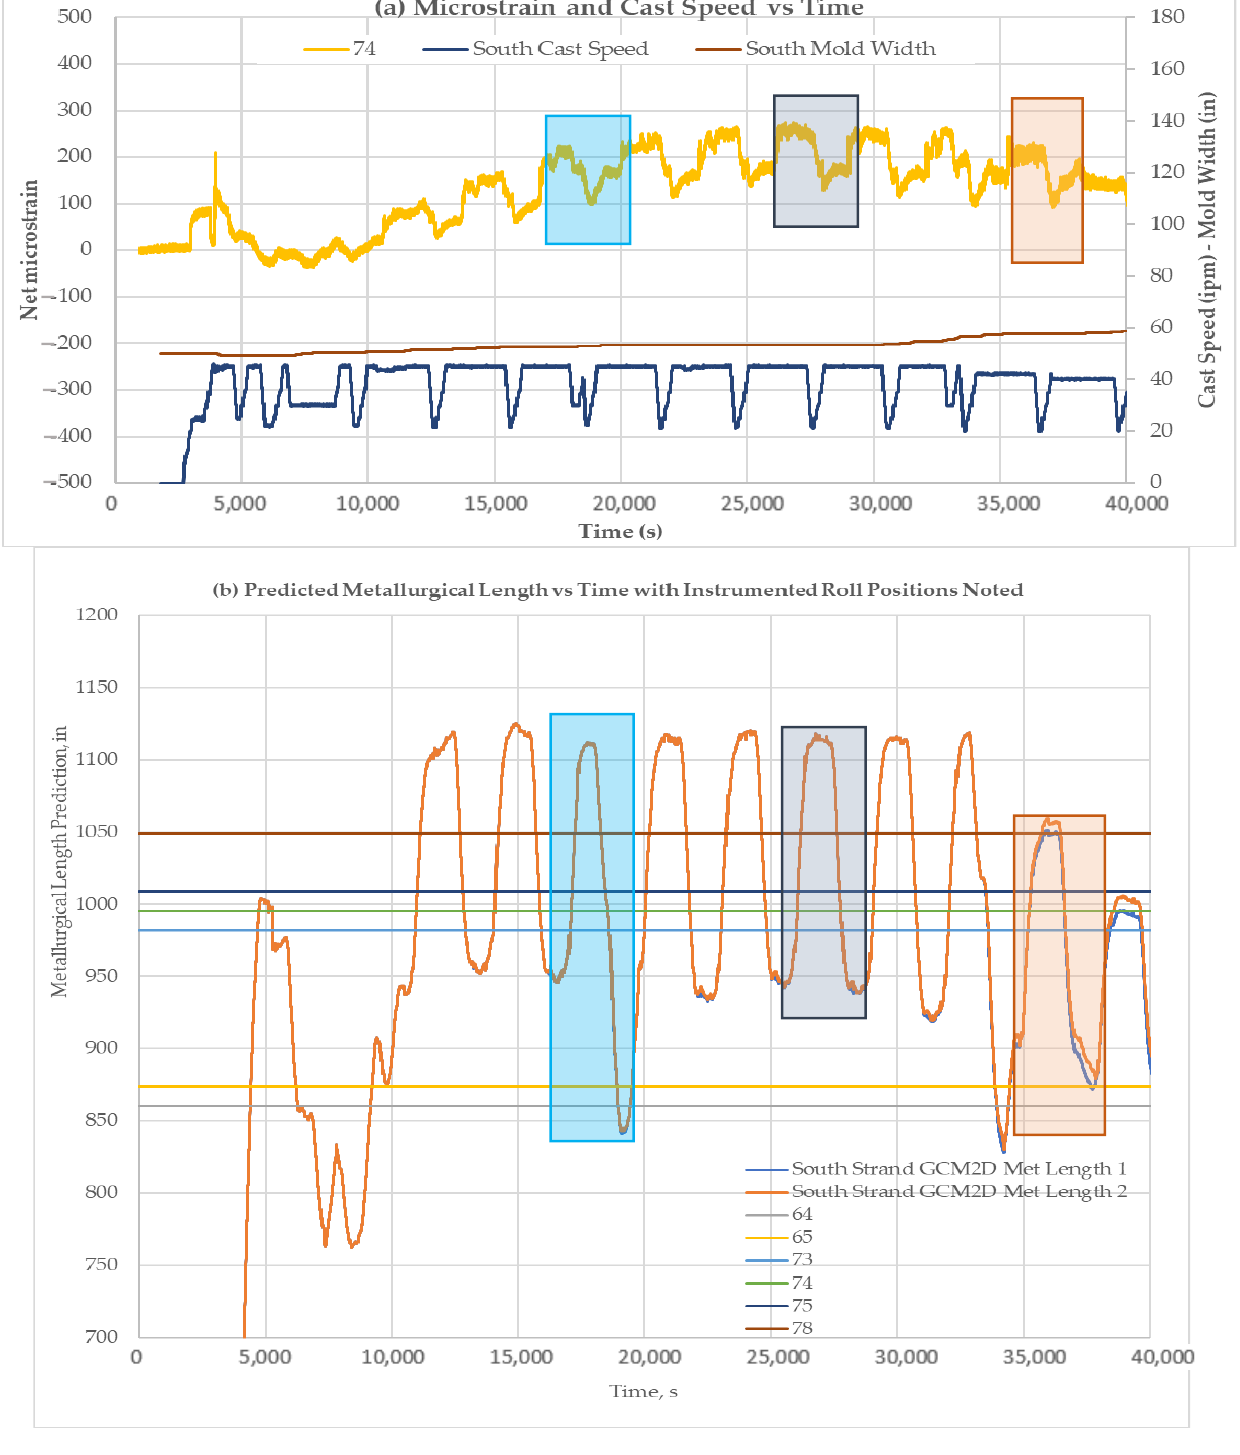
Figure 21. Liquid core position and corresponding net roll strains for the first 12 heats of the 20-heat cast sequence with liquid core locations highlighted for Roll-74. ( a ) Microstrain and cast speed is plotted against time. Three sections (highlighted by rectangles) were chosen to be compared with metallurgical length. ( b ) Predicted metallurgical lengths for different time periods. Strain comparison for sections highlighted in Figure 22a with metallurgical lengths.